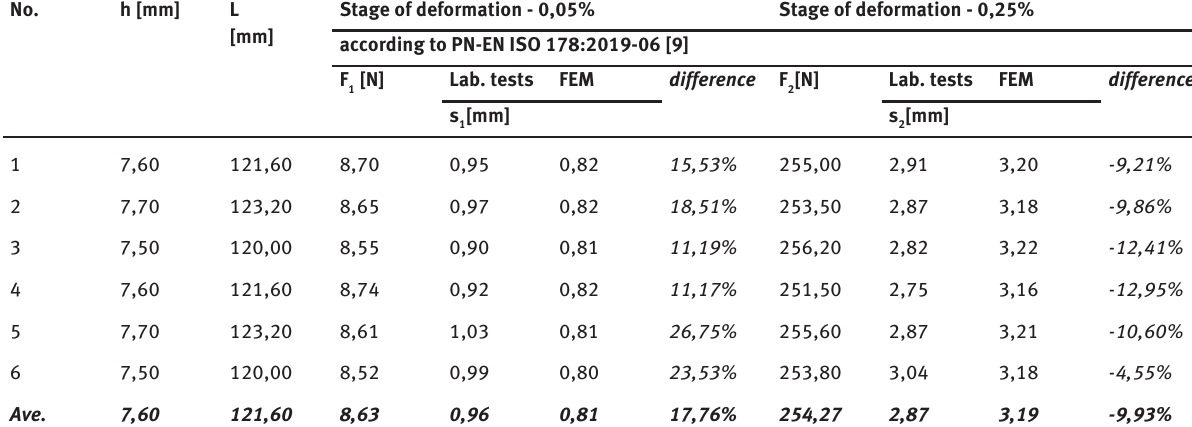
Table 6: Comparison of results of numerical analyses and laboratory tests for a model of a liner with a diameter of 200mm and 7,50mm wall